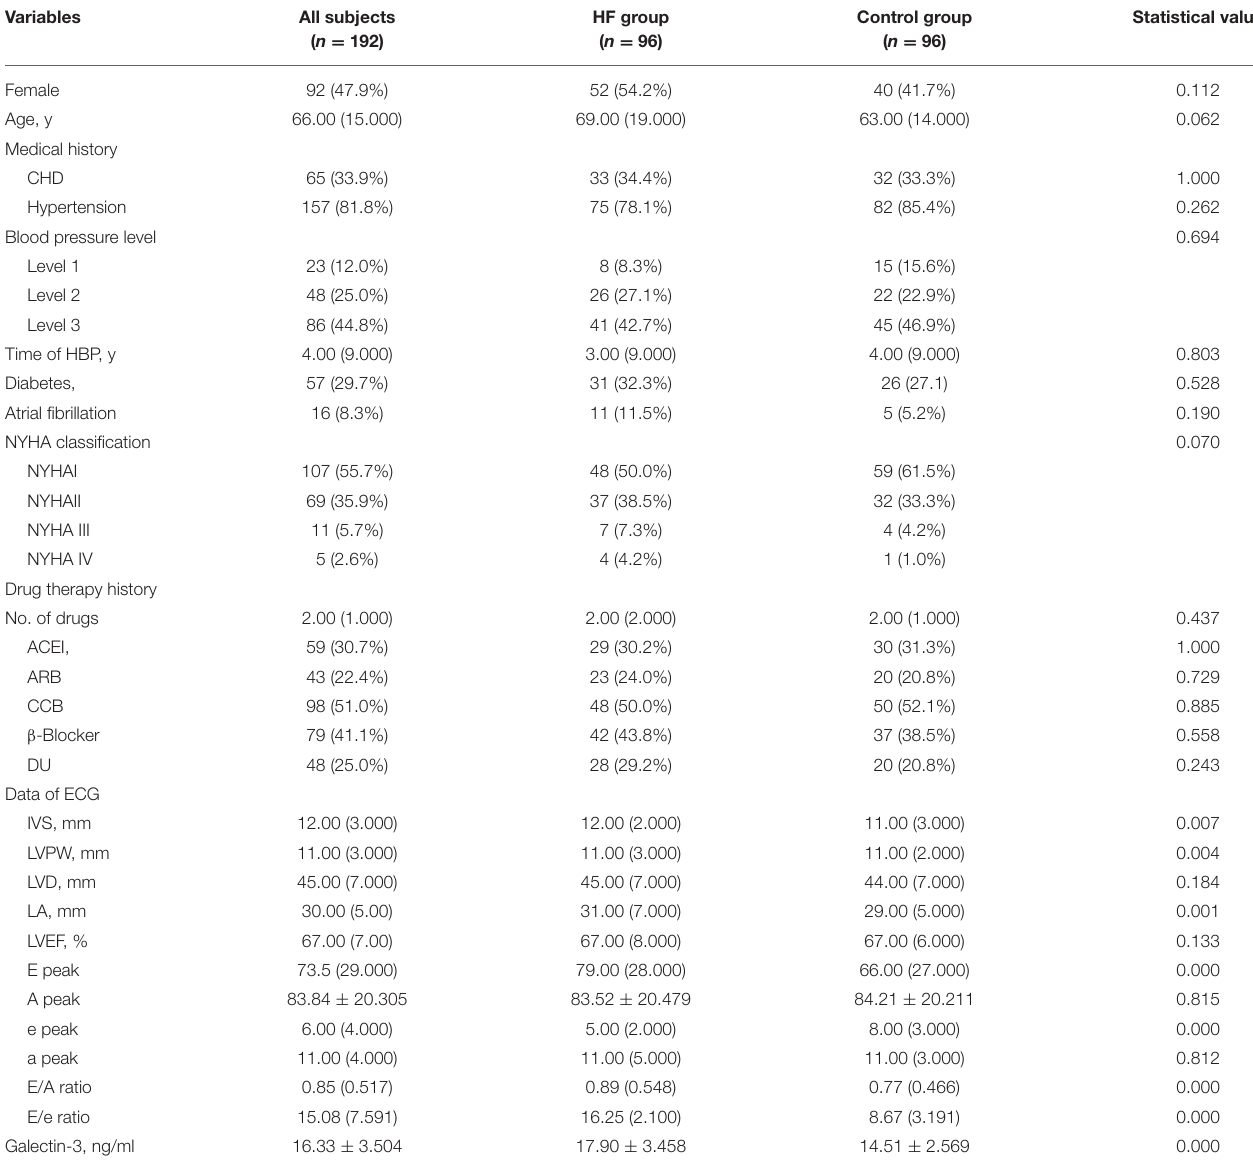
TABLE 1 | Baseline demographic and clinical features of the study